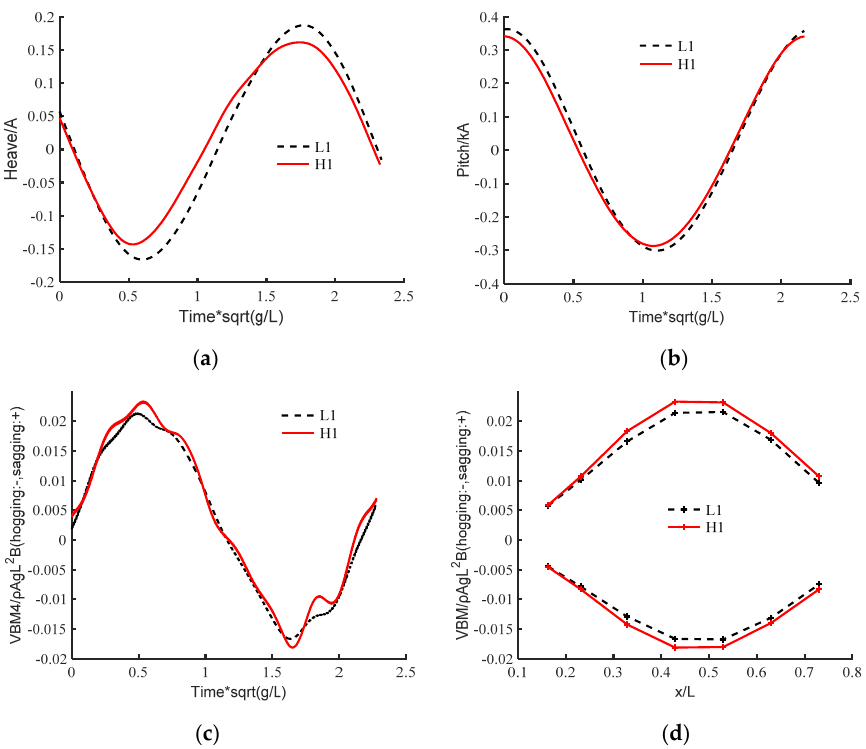
Figure 14. Comparison of structural response between L1 and H1. ( a ) time series of Heave; ( b ) time series of Pitch; ( c ) time series of VBM4; ( d ) VBM at seven sections.